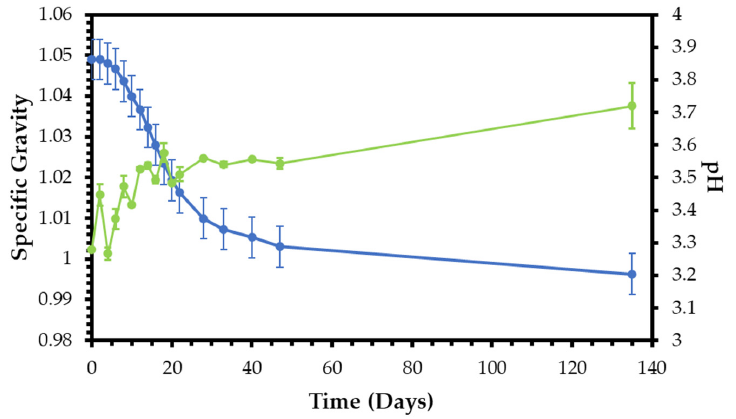
Figure 3. Specific gravity ( blue ) and pH ( green ) are shown for the entire fermentation and maturation process. On the left y-axis, the average specific gravity of three Gravenstein apple cider fermentations is plotted against time. The right y-axis shows pH measurements for the fermentations. Day 0 corresponds to measurements taken of pre-inoculated apple juice in triplicate and Day 135 represents the end of cider maturation (prior to dry hopping).